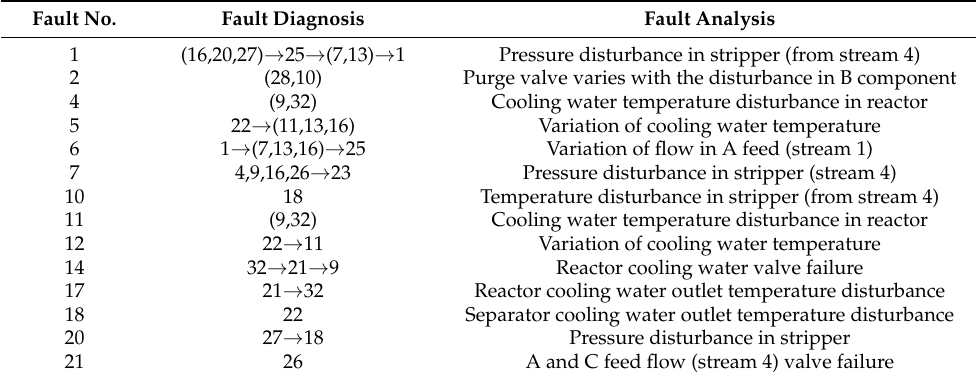
Table 3. Fault diagnosis results in TEP determined by the proposed